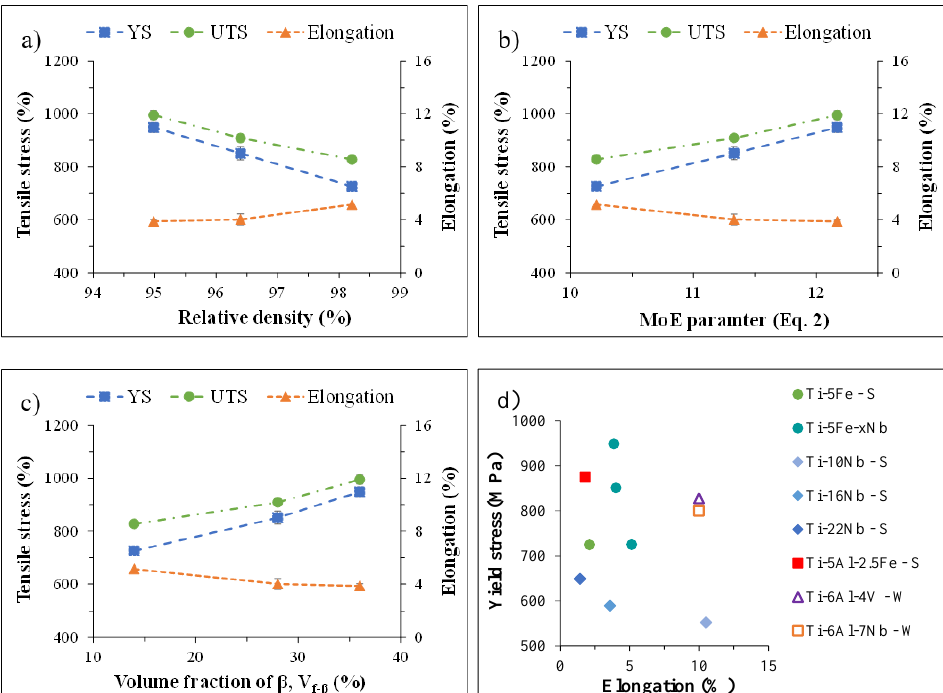
Figure 7. Average mechanical properties of the Ti-5Fe-xNb alloys as a function of the relative density ( a ), the MoE parameter as calculated by means of Equation (2) ( b ), and V f- β , the volume fraction of phase β ( c ); and comparison of the yield stress/elongation pairs with literature ( d ) [27,37,43,44]. Legend: S-sintered, and W-wrought.